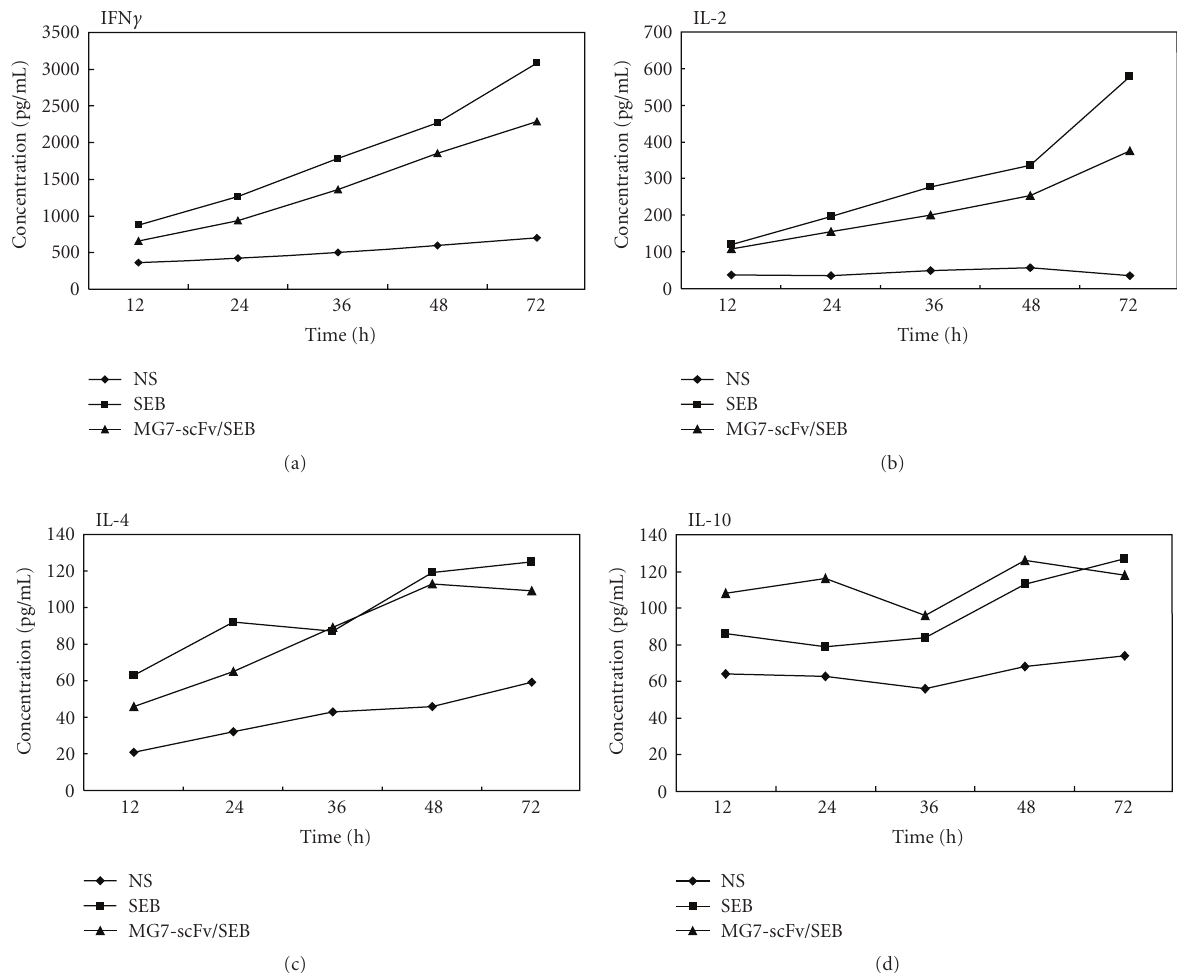
Figure 6: Production of cytokines by stimulated PBMCs: (a) IFN- γ production, (b) IL-2 production, (c) IL-4 production, (d) IL-10 production. The productions of IFN- γ and IL-2 are much more than those of IL-4 and IL-10 ( P < . 05). It indicated that SEB mainly activates Th1 cell to upregulate cellular immunity; meanwhile, it slightly activates Th2 cell.